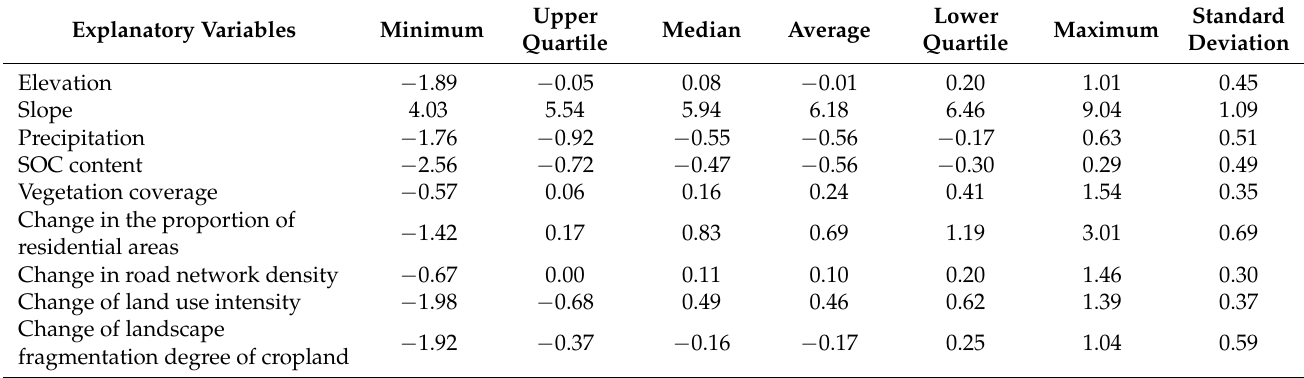
Table 4. Statistical result of regression coefficients of explanatory variables.